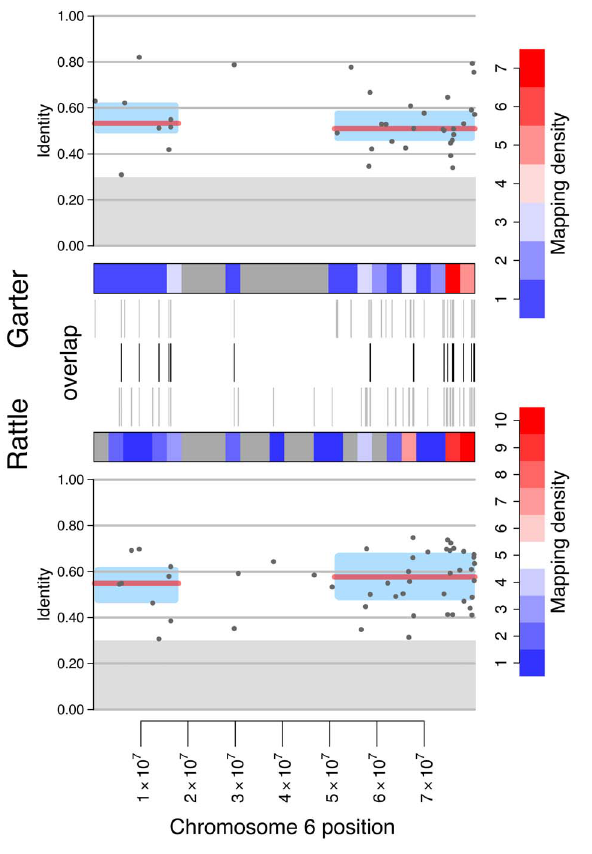
Figure 3. Evolutionary strata and sequence conservation between the pygmy rattlesnake and garter snake W-candidate scaffolds mapped along the Z chromosome. The middle three tracks show the position of candidate W sequences along the Z chromosome in garter snake (top) and pygmy rattlesnake (bottom), and their overlap (center). The top and bottom plots show nucleotide identity between Z-W gametologs (grey dots), and the median (red line) inferred for each of the putative strata for garter snake and pygmy rattlesnake (blue boxes; the y range of the boxes represents the interquantile range of the identity values in each region). The gray shaded region represents identity below 30%, indicating low quality mapping. As in Figure 2, the data in this figure contain both non-coding and coding scaffolds.